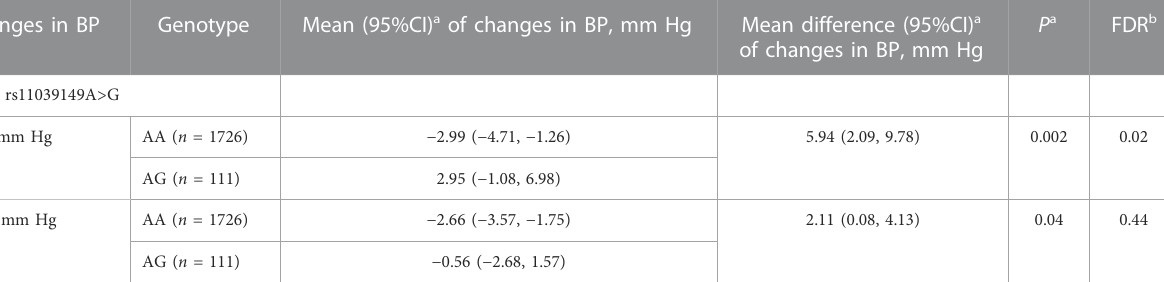
TABLE 2 Effects of NR1H3 variant rs11039149A > G on changes in blood pressure. Changes in